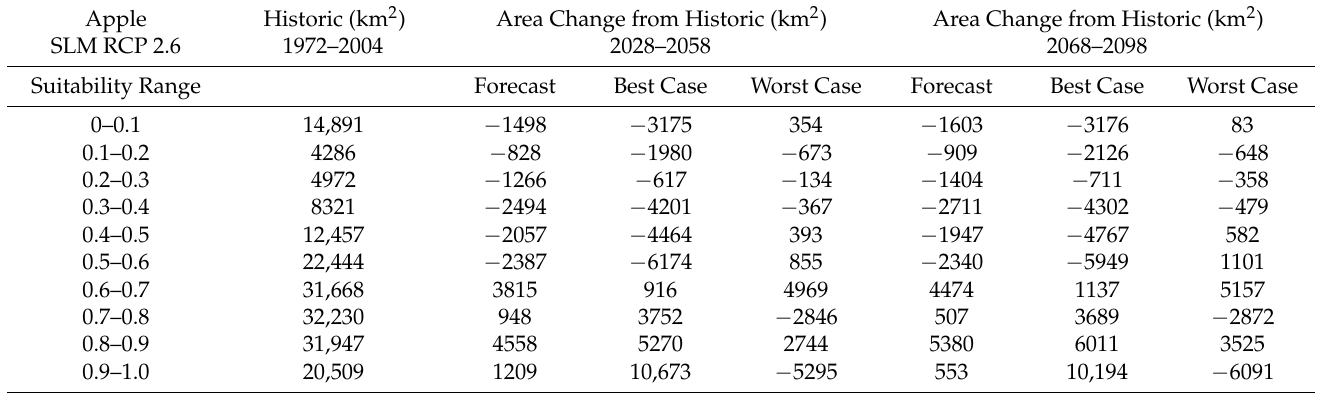
Table A2. Apples: land area in the historic period falling into different cultivation suitability ranges, forecast change for the mid- and late-century under RCP 2.6 and best and worst